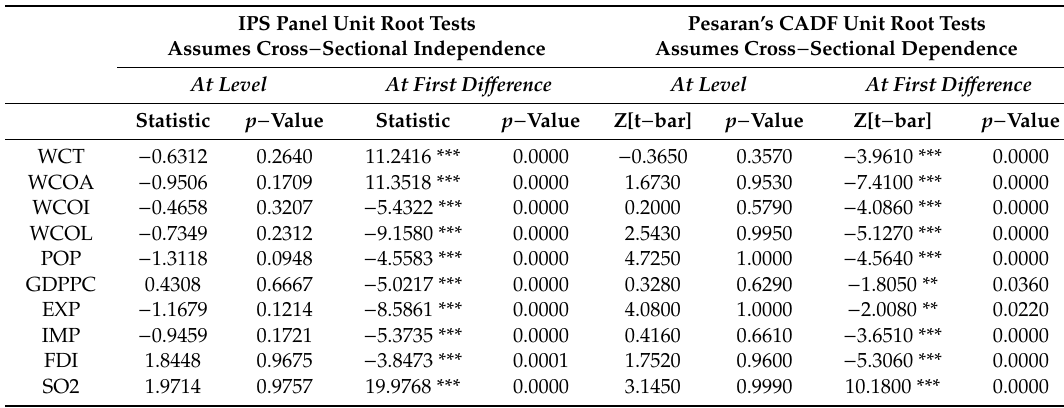
Table 5. Panel unit root tests (whole of